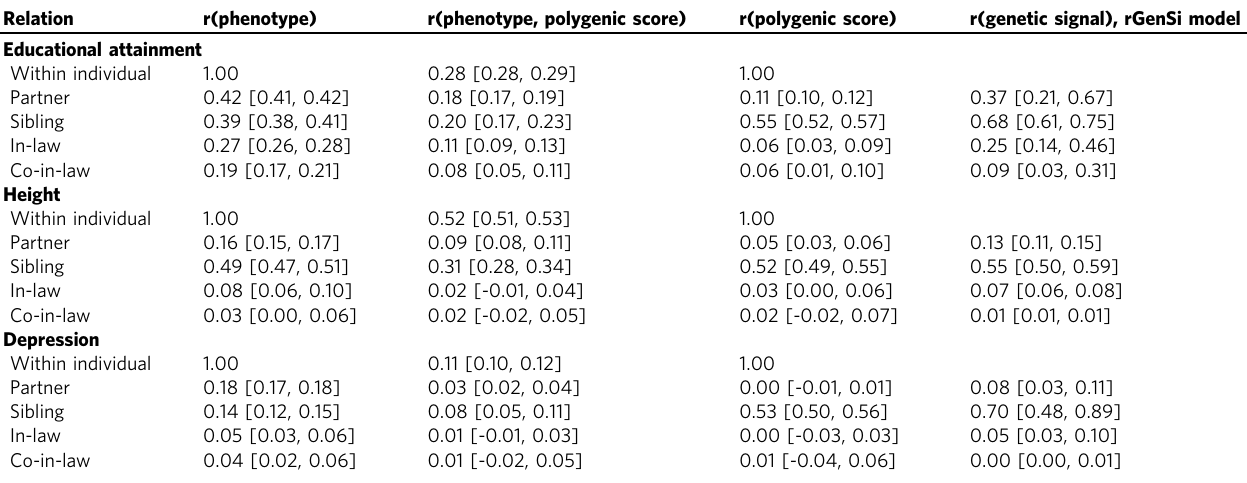
Note: The fi rst column shows phenotypic Pearson correlations between partners, siblings, in-laws, and co-in-laws; the second column shows Pearson correlations between the phenotype in one relative and the polygenic score in another; the third column shows Pearson correlations of the polygenic scores in different individuals; the fourth column shows similarity in trait-associated genetic factors estimated with the rGenSi model to adjust for noise in the assessment of polygenic scores and phenotypes. Based on 26,681 pairs of partners, 2170 pairs of siblings, 3905 pairs of siblings-in-laws, and 1763